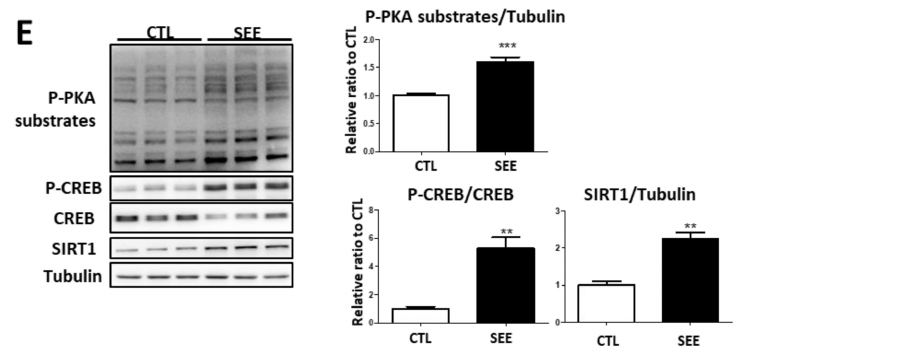
Figure 2. E ff ects of in vitro SEE treatment on mitochondrial function and PKA signaling in adipocytes. ( A ) Immunoblot analysis of uncoupling protein 1(UCP1) and mitochondrial proteins involved in oxidative phosphorylation in adipocytes di ff erentiated from C3H10T1 / 2 cells treated with vehicle (CTL) and SEE (160 µ g / mL) for 24 h; ( B ) analysis of oxygen consumption rate (OCR) of adipocytes di ff erentiated from C3H10T1 / 2 cells treated with vehicle (CTL), and SEE (160 µ g / mL) for 24 h with a series of treatments of indicated drugs (Oligomycin, Carbonyl cyanide-4 (trifluoromethoxy)phenylhydrazone (FCCP), rotenone and antimycin A). Arrows of (B) indicate the time of the treatments; ( C ) comparisons of basal mitochondrial respiration and ATP-linked respiration between cells treated with vehicle and SEE; ( D ) MitoTracker staining of adipocytes di ff erentiated from C3H10T1 / 2 cells treated with vehicle (CTL) and SEE (160 µ g / mL) for 24 h. size bar = 20 µ m ( n = 6, means ± SEM, * p < 0.05, ** p < 0.01, *** p < 0.001); ( E ) immunoblot analysis of p-CREB, CREB, SIRT1, and p-PKA substrates in